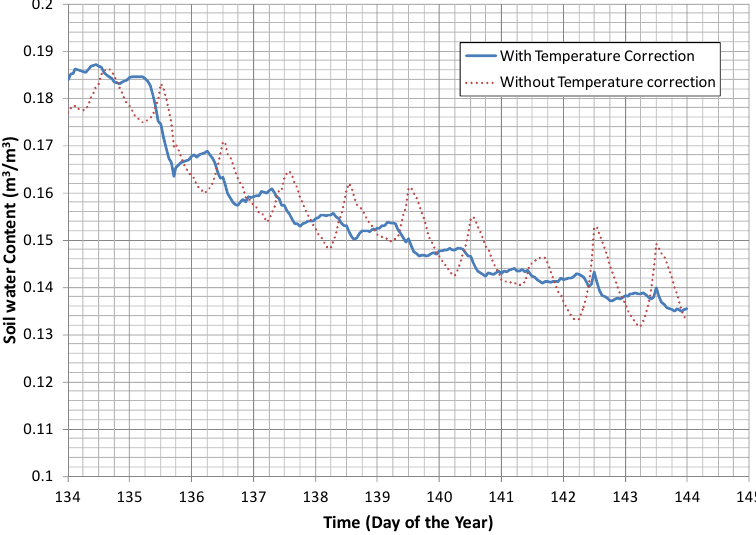
Figure 6. Soil water content measured by the HMS9000 located at a 2.5-cm depth. The probe calibration was done either with the unprocessed measurement (dotted line) or with the measurement corrected by the temperature effect (solid line). Solid grids at 134, 135 … correspond to midnight.